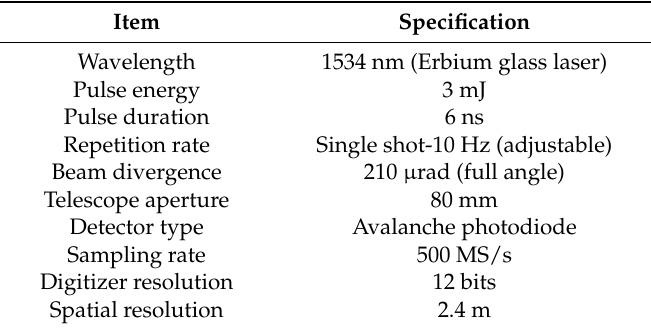
Table 2. Lidar system